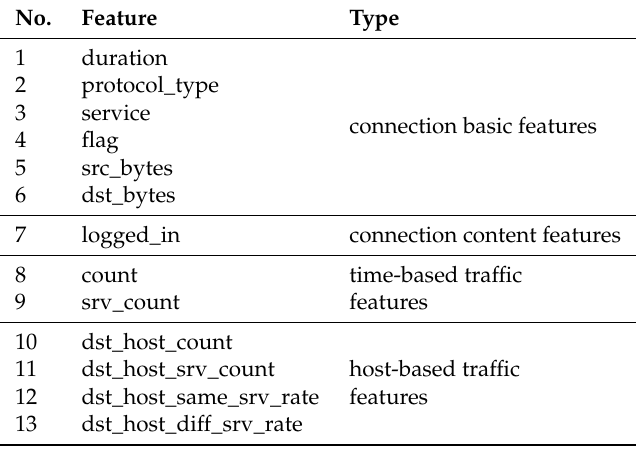
Table 3. Features of transactions on the KDD99